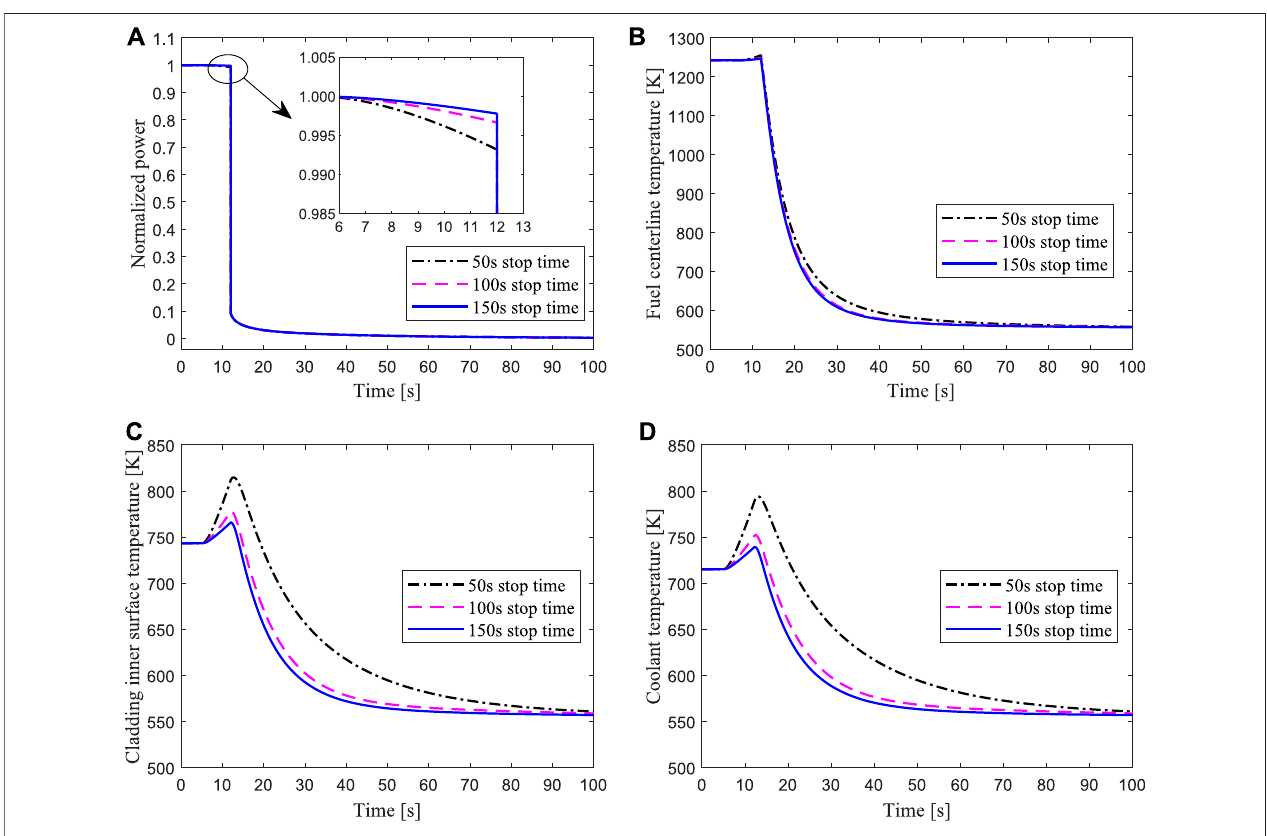
FIGURE 15 | Transient responses of the hottest channel for protected loss of fl ow due to 50, 100, 150 s pump coastdown respectively.